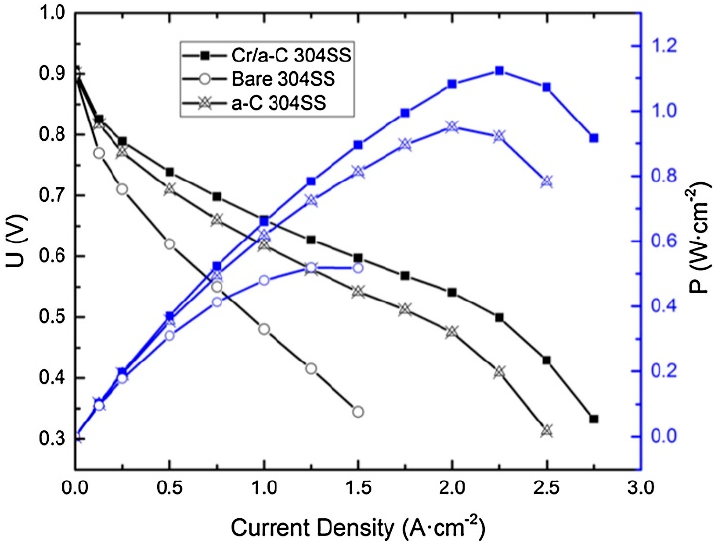
Figure 3. Outputs of assembled fuel cells with different bipolar plates. Reprinted from [26] copyright (2016), with permission from Elsevier.